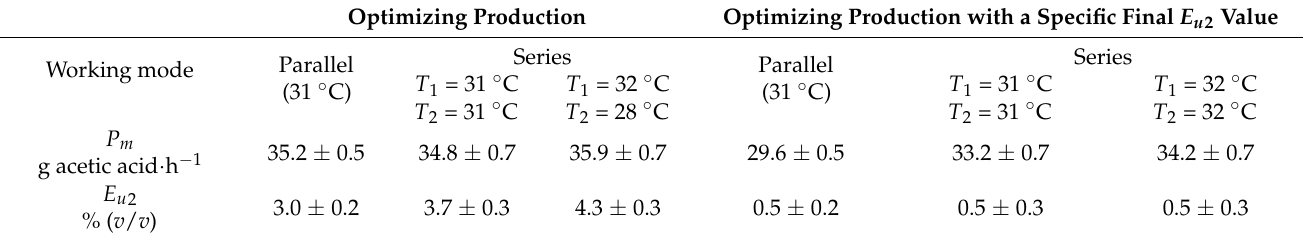
Table 14. Comparison of acetic acid production and final ethanol concentration at the time of unloading with two bioreactors operating in series and in